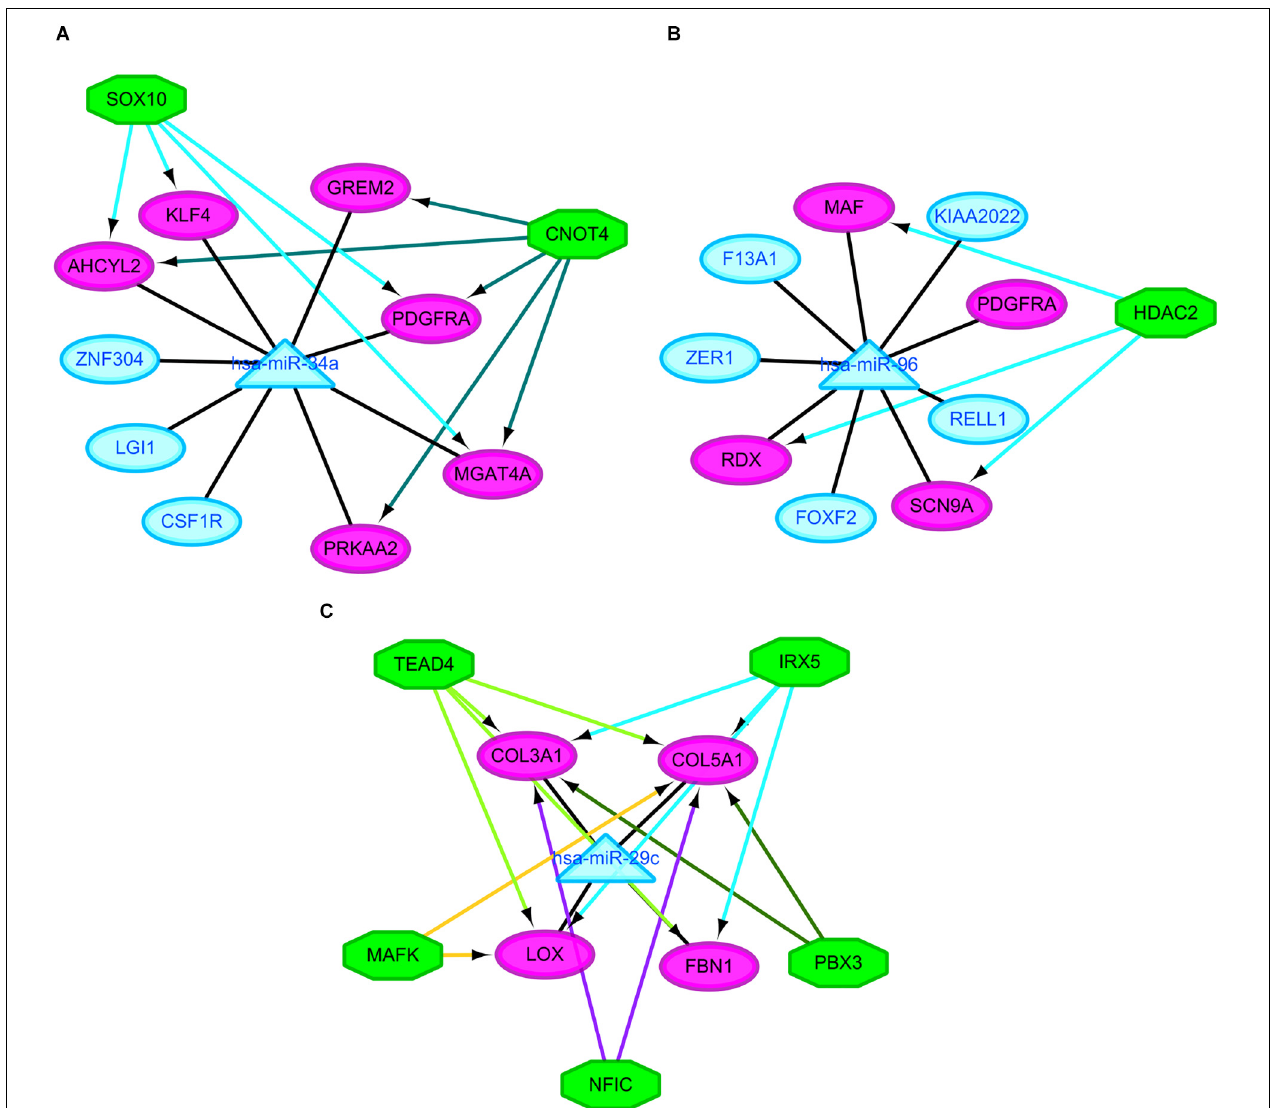
FIGURE 5 | Regulatory networks of the key miRNAs, target genes and transcription factors. (A) Network of hsa-miR-34a and 2 transcription factors; (B) network of hsa-miR-96 and one transcription factor; (C) network of hsa-miR-29c and 5 transcription factors. Green octagons indicate transcription factors. Purple circles indicate target genes regulated by key miRNAs and transcription factors, blue circles indicate target genes regulated by key miRNAs and triangles indicate key miRNAs. miRNA,